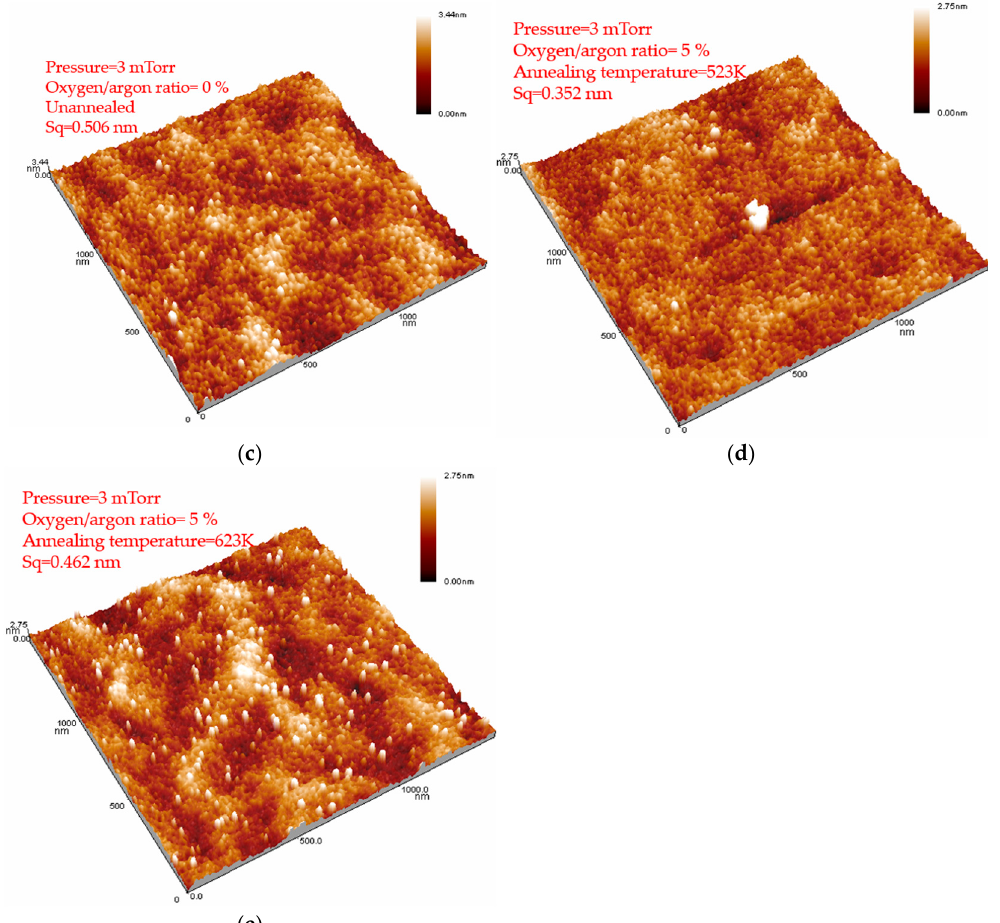
Figure 2. ( a – e ) AFM images of ZATO films at different pressure, oxygen contents and annealing temperatures.